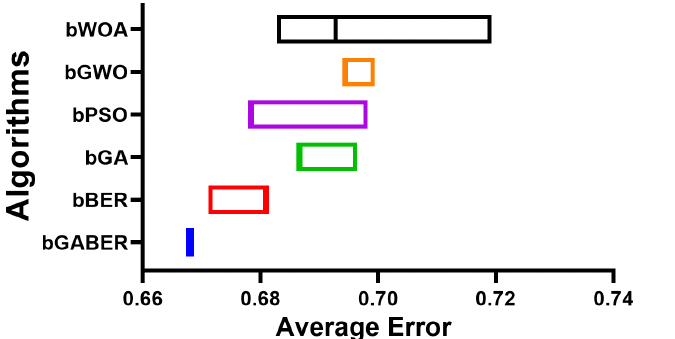
Figure 8. Average error of the results achieved by the proposed feature selection method compared to other methods based on the wind speed dataset.